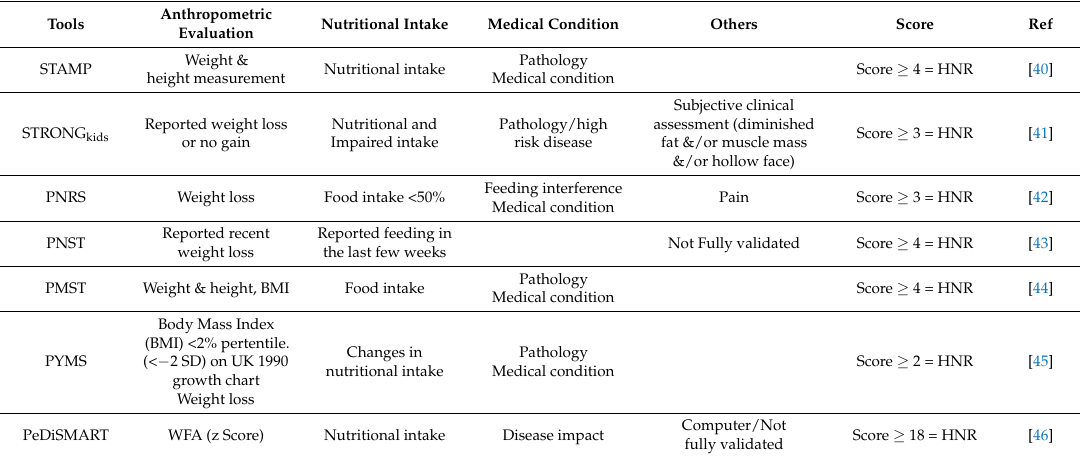
Table 1. Pediatric nutritional screening